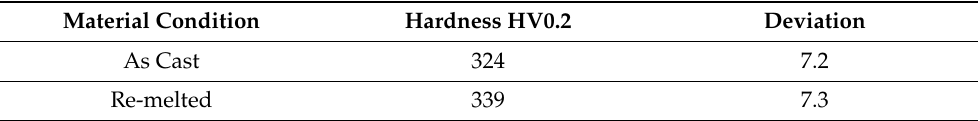
Table 6. Hardness of the used